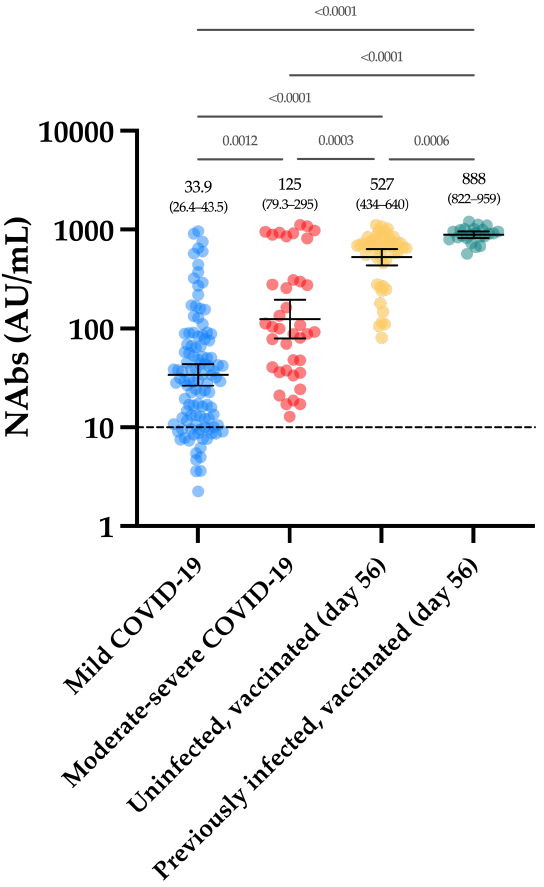
Figure 5. NAb titers obtained in the first group (moderate–severe and mild COVID-19), compared to those obtained in the group of vaccinated participants, at day 56. The black dotted line corresponds to the positivity threshold of 10 AU/mL.